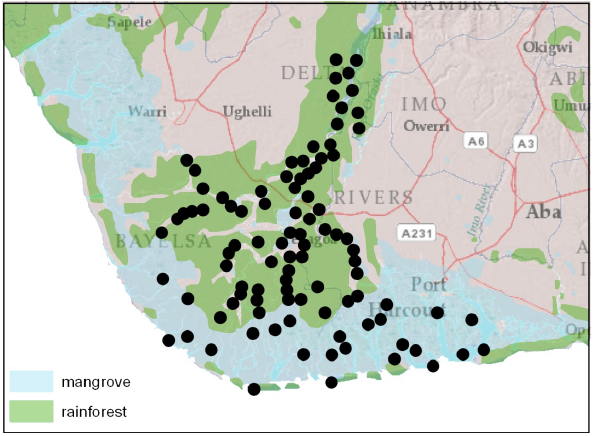
Figure 1. Map of the Niger Delta region, southern Nigeria (West Africa). Dots indicate study sites from where interview and sighting data were